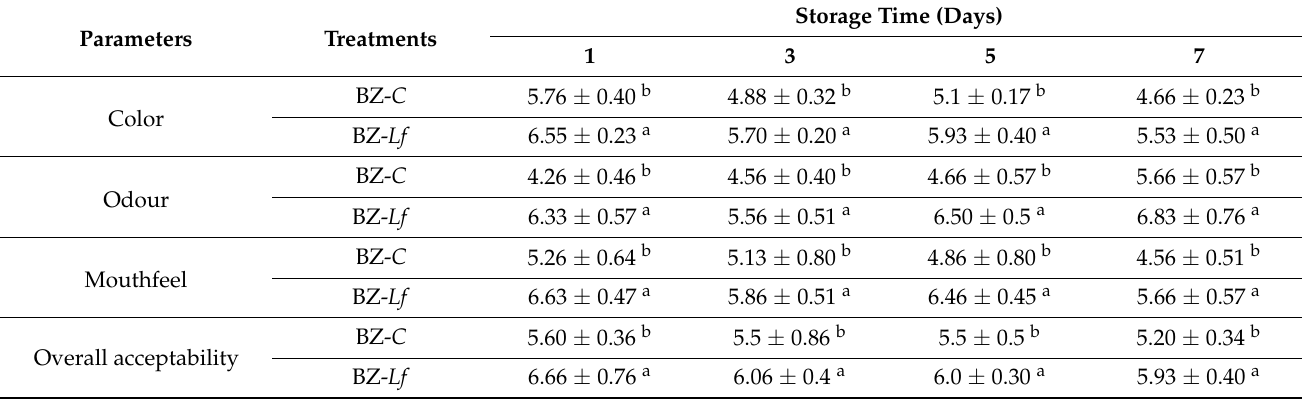
Table 3. Changes in organoleptic properties of Bozai samples during storage of 7 days at 4 ◦ C.